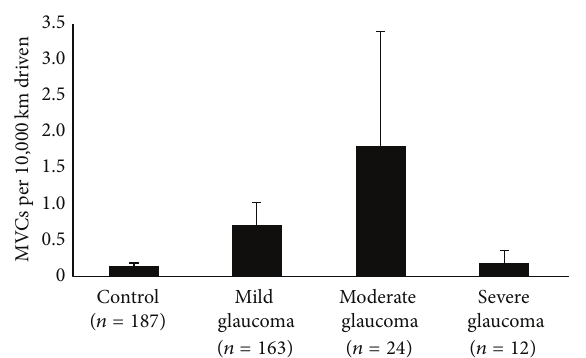
Figure 2: The association between the number of MVCs per 10,000 km driven and glaucoma severity, grouped by better eye. No significant association was observed between the accident rate and glaucoma severity, grouped by better eye ( 𝑃 = 0.08 , Jonckheere- Terpstra test). MVC (motor vehicle collision). Error bar: standard error.